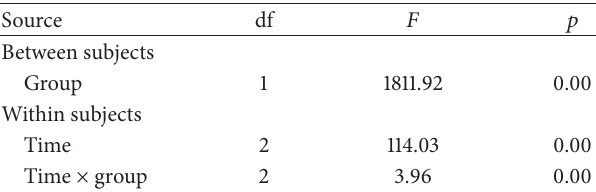
Table 8: Two-way repeated measures ANOVA analysis for the productive posttests.